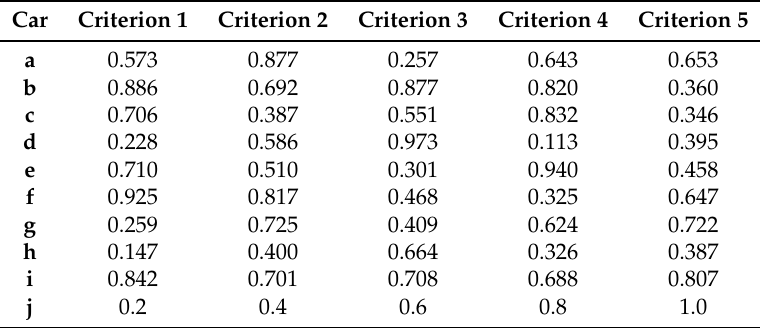
Table 2. The partial evaluations of candidate